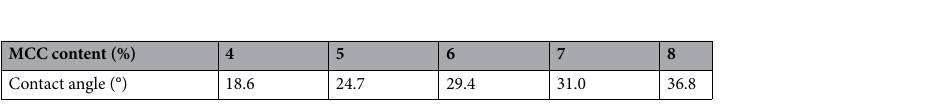
Figure 5. Contact angle photo of membranes prepared from casting solutions with different MCC content.